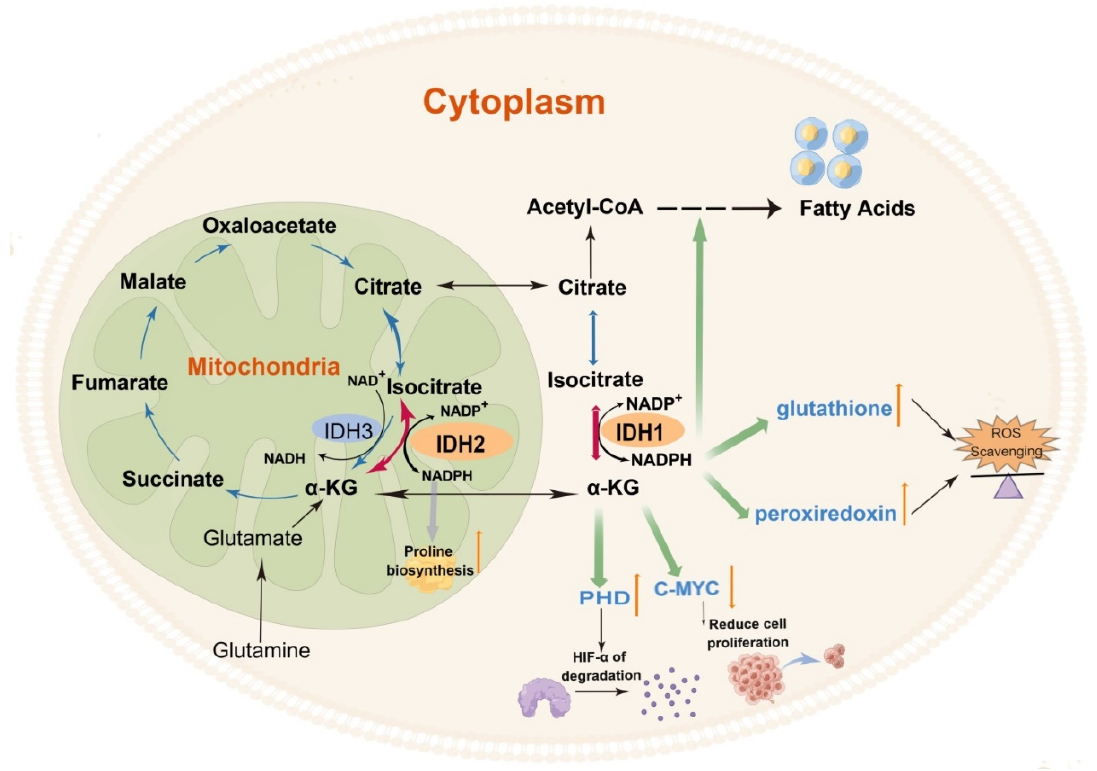
Figure 2. The role of wild-type IDH in human cells. The reaction catalyzed by IDH1 and IDH2 provides NADPH to maintain the pool of reduced glutathione and peroxiredoxin that counteract reactive oxygen species (ROS). The reaction catalyzed by IDH1 and IDH2 provides α -KG to increase the activity of the prolyl hydroxylase domain (PHD) and downregulate c-Myc expression. IDH3, the key enzyme of the TCA cycle, serves as the central regulatory site of the TCA cycle. (By Figdraw). Oxidative TCA catalyzed by IDH1 and IDH2 is accompanied by the production of NADPH to balance the cellular redox equilibrium [28] and maintain the pool of reduced glu- tathione and peroxiredoxin that counteract reactive oxygen species (ROS) [29], protecting cells from oxidative damage, lipid peroxidation, and DNA damage [29,30]. Craig B.